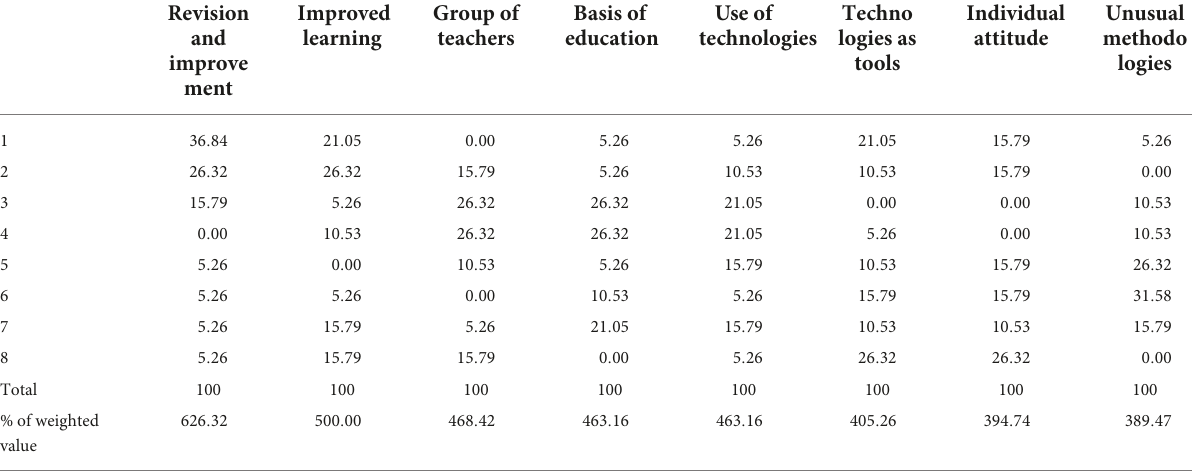
TABLE 5 Ideas on the concept of educational innovation, from highest to lowest